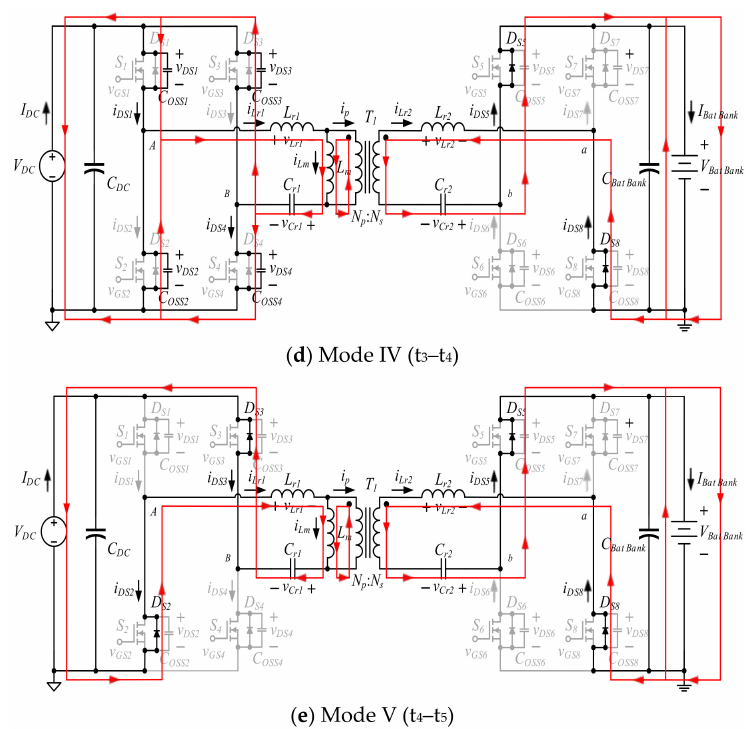
Figure 7. Circuit diagrams of the proposed bidirectional CL 3 C full-bridge resonant converter for operation in the charging mode: ( a ) Mode I, ( b ) Mode II, ( c ) Mode III, ( d ) Mode IV, and ( e ) Mode